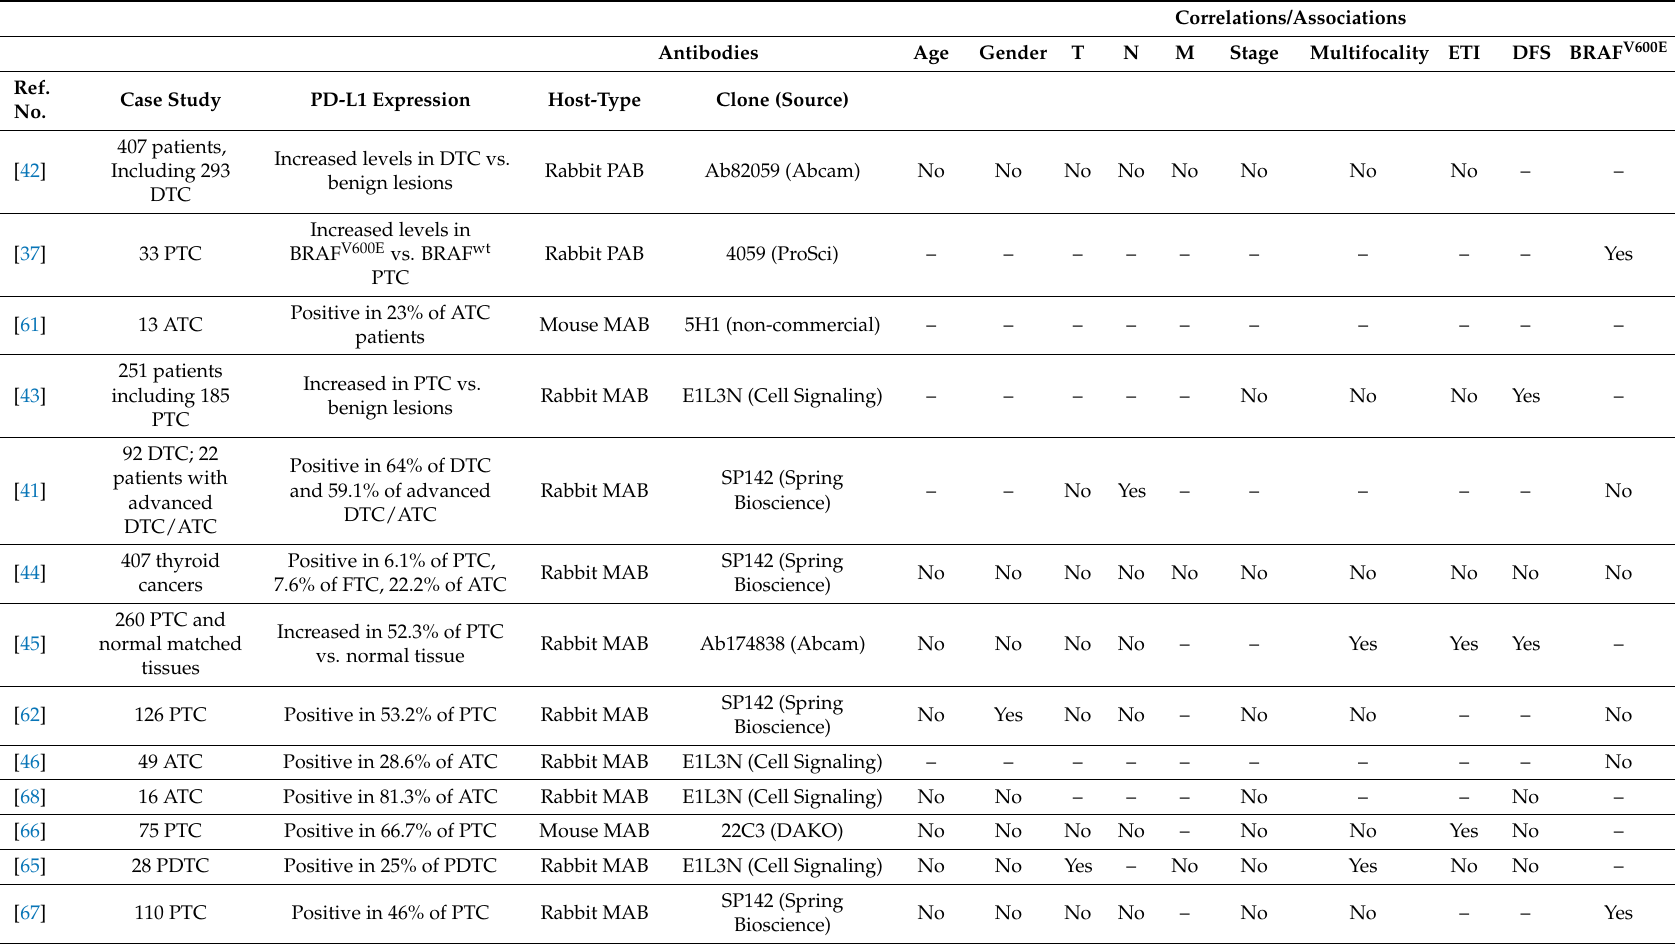
Table 1. Association of PD-L1 protein levels with clinico-pathological features and BRAF mutational status in thyroid cancer patients. ETI, extra-thyroidal invasion; DTC, differentiated thyroid cancer; PTC, papillary thyroid cancer; ATC, anaplastic thyroid cancer; FTC, follicular thyroid cancer; PDTC, poorly differentiated thyroid cancer; –, non-evaluated; DFS, disease-free survival; MAB, monoclonal antibody; PAB polyclonal antibody.